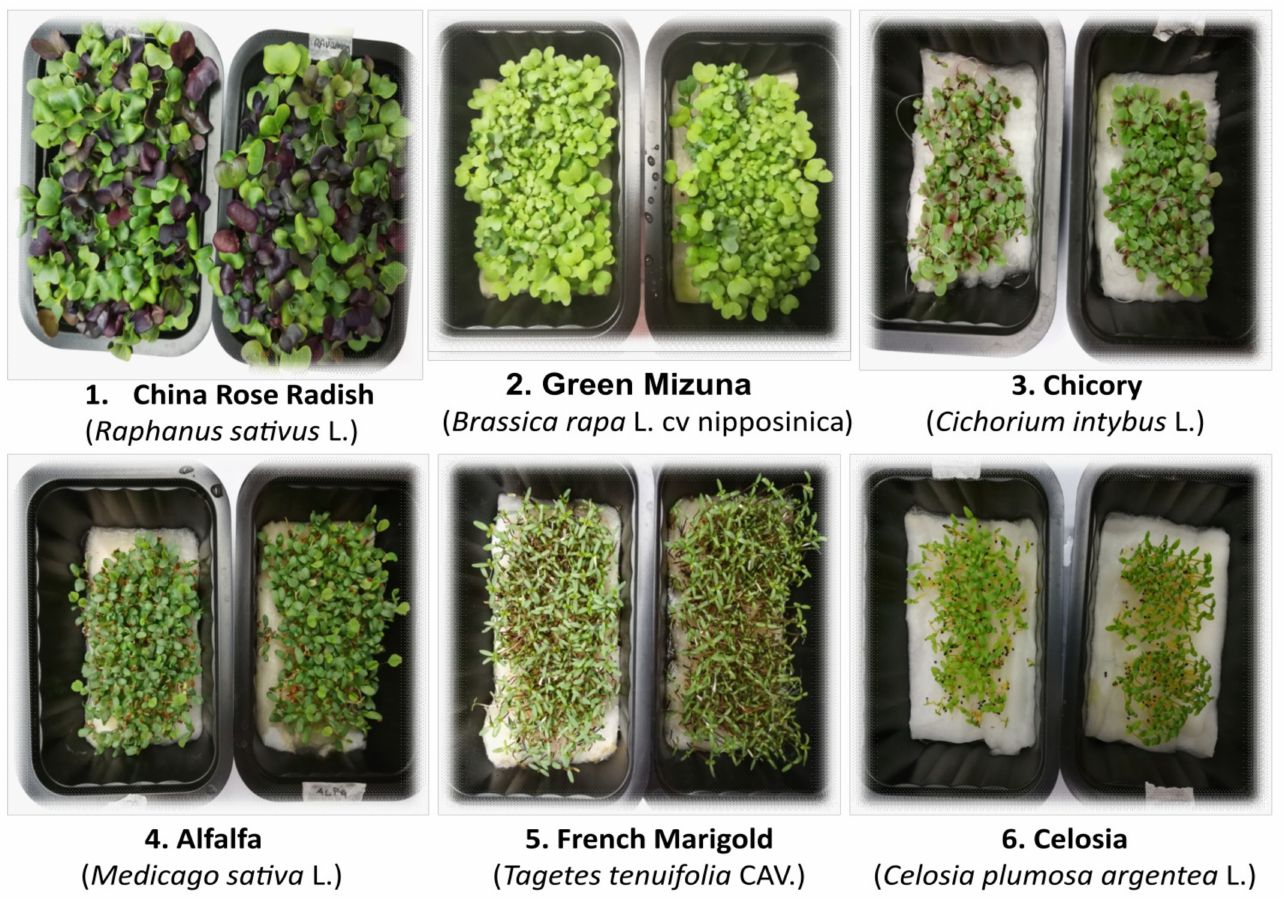
Figure 1. Microgreen species used in this